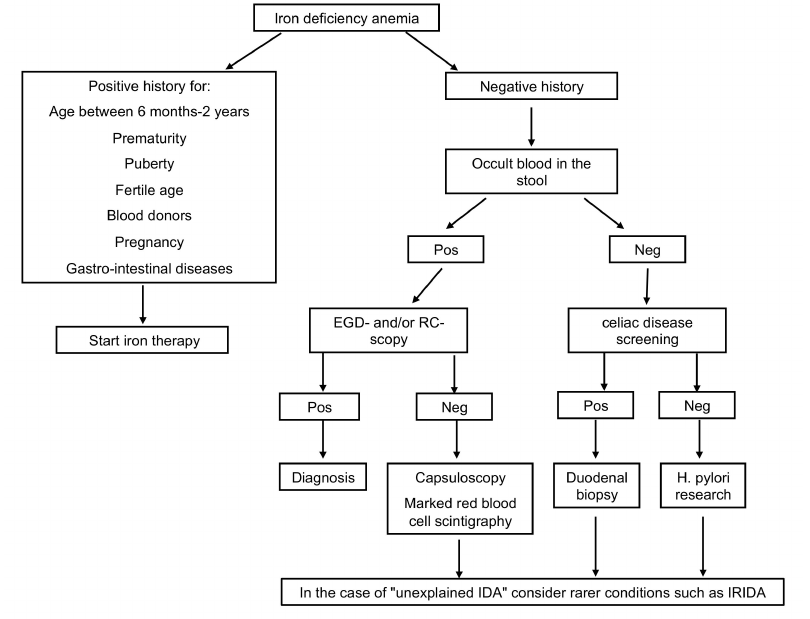
Figure 1. Diagnostic workup in case of IDA. EGD-scopy, esophagogastroduodenoscopy; RC-scopy, rectoscopy; Pos, positive; Neg, negative; H.pylori , Helicobacter pylori ; IDA, iron deficiency